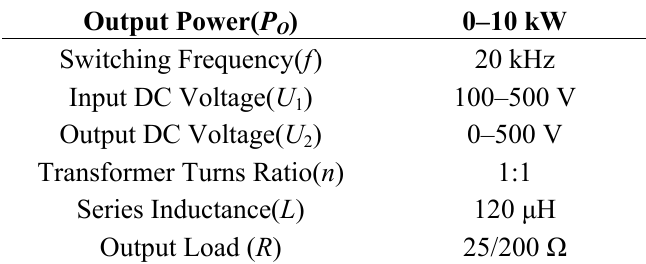
Table 3. The parameters of